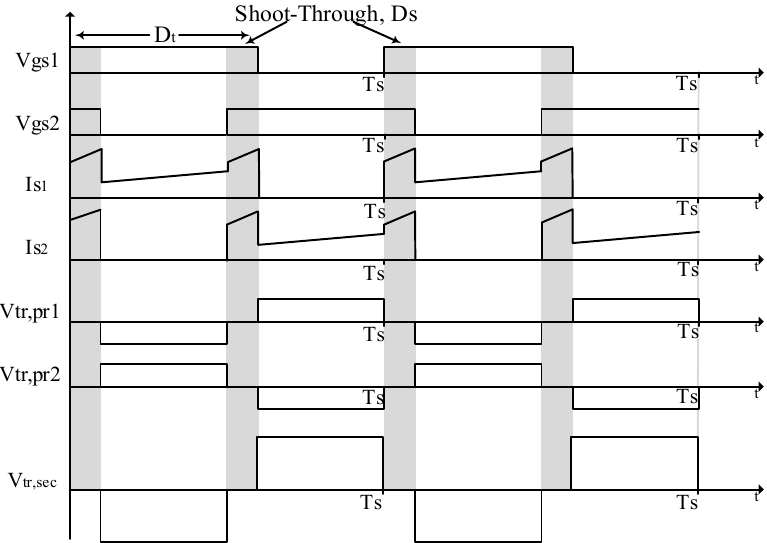
Figure 3. Equivalent circuits of the converters: ( a ) Full power QZSC, ( b ) Basic PPP QZSC, ( c ) Proposed PPP QZSC.